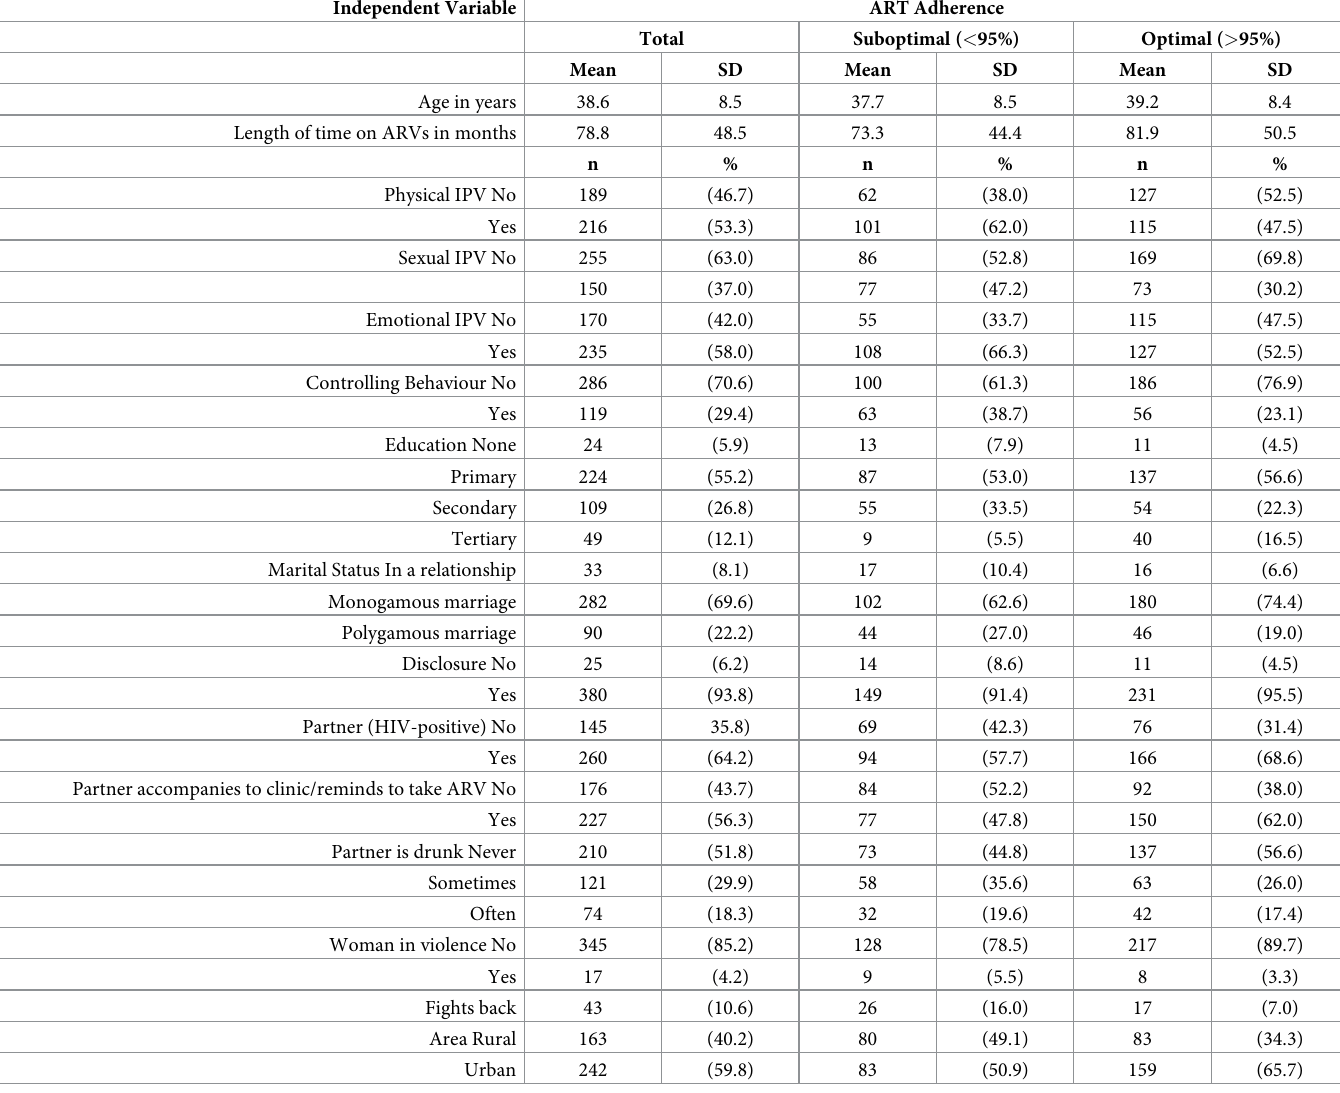
Table 1. Participant’s demographics, total and relative frequencies of IPV, and other variables stratified by optimal or suboptimal ART